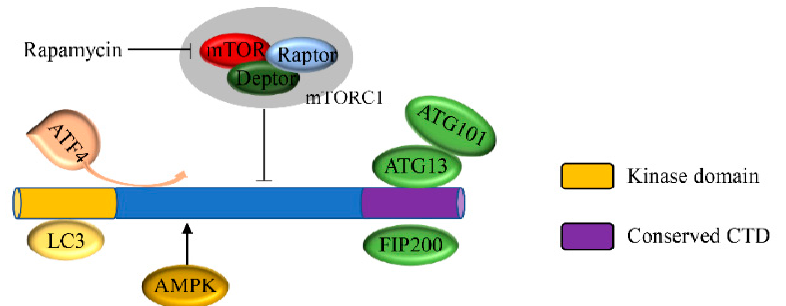
Figure 1. Structure and biological function of ULK1. The domain of ULK1 contains three units including a kinase domain (KD), proline / serine-rich (PS) region, and C-terminal domain (CTD). AMPK and mTORC1 are upstream kinases that regulate ULK1. ATF4 is an activating transcription factor that directly regulates transcription of